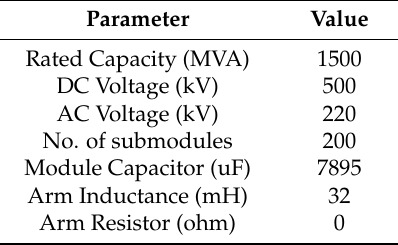
Table 4. MMC parameters.